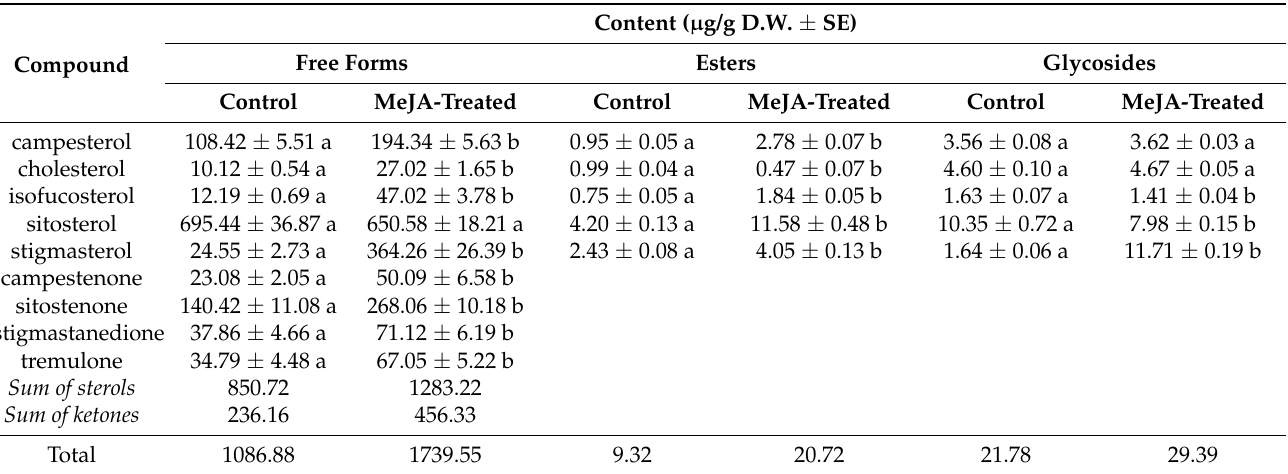
Table 3. The content of steroids in the T. × media ATMA (harboring the TXS transgene) hairy root line after elicitation with 100 µ M